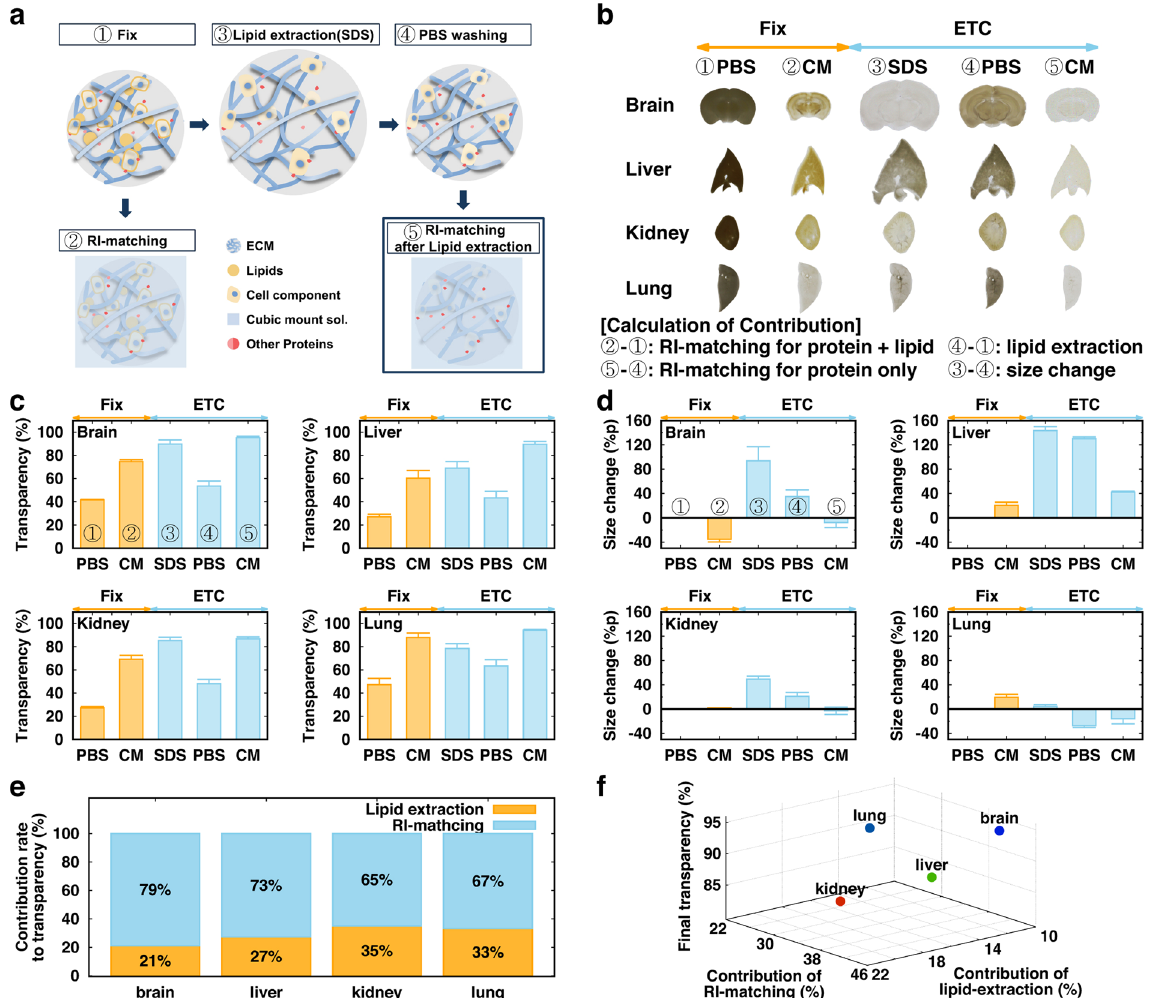
Figure 1. ACT process and contributions of lipid-extraction, RI-matching, and size expansion to tissue transparency (a) Schematic diagram of refractive index (RI) matching and the active CLARITY technique (ACT) process. (b) Images of 1-mm-thick tissue slices during the tissue-clearing process. Comparison of two different steps provides contributions of each factor (bottom) (c) Transparency of each organ tissue during the tissue-clearing process. (d) Size changes of each organ at each tissue-clearing step. (e) Contributions of RI- matching and lipid extraction to tissue clearing, if the effect of size change on transparency is compensated. (f) 3D plot of contributions of lipid-extraction and RI-matching to tissue transparency. The color indicates the final transparency (red-green-blue). N = 3 for each